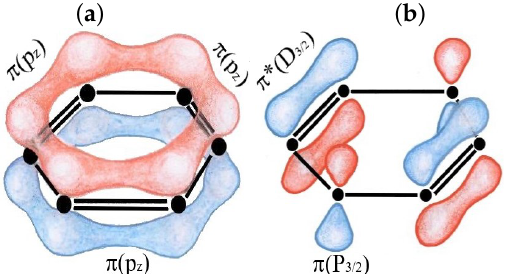
Figure 1. Graphene cell models with three dimers per hexagonal cell so that the electron density of the dimers overlaps ( a ) and with two conjugated double bonds and one “broken” π -bond ( b ) that π - and π ∗ -electrons are on terms P 3/2 and D 3/2 with a total angular momentum J = 3/2. The equality of P 3/2 - and D 3/2 -terms energies in the case of relativistic hydrogen-like atom provides the stability of configurations with two